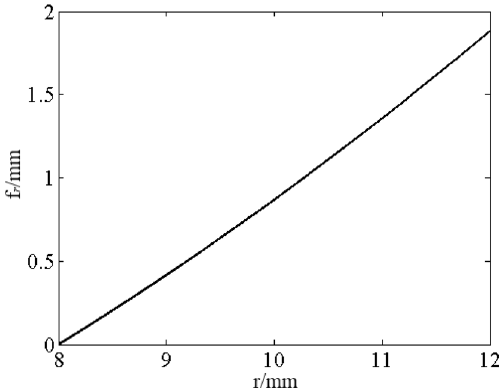
Figure 2. Deformation curve of valve